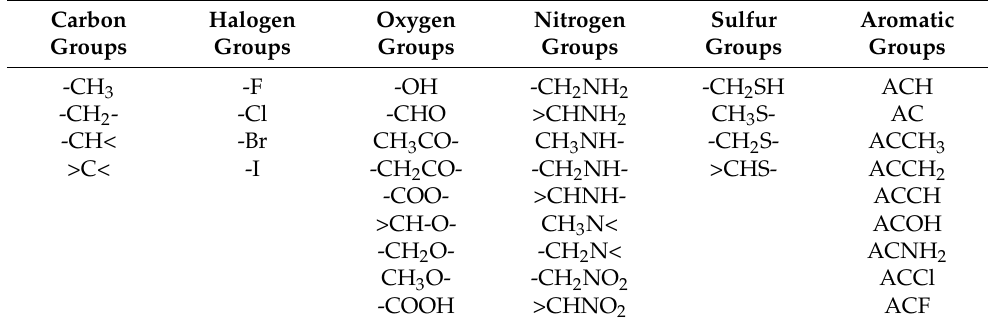
Table 2. Basic set of candidate functional groups for ORC working